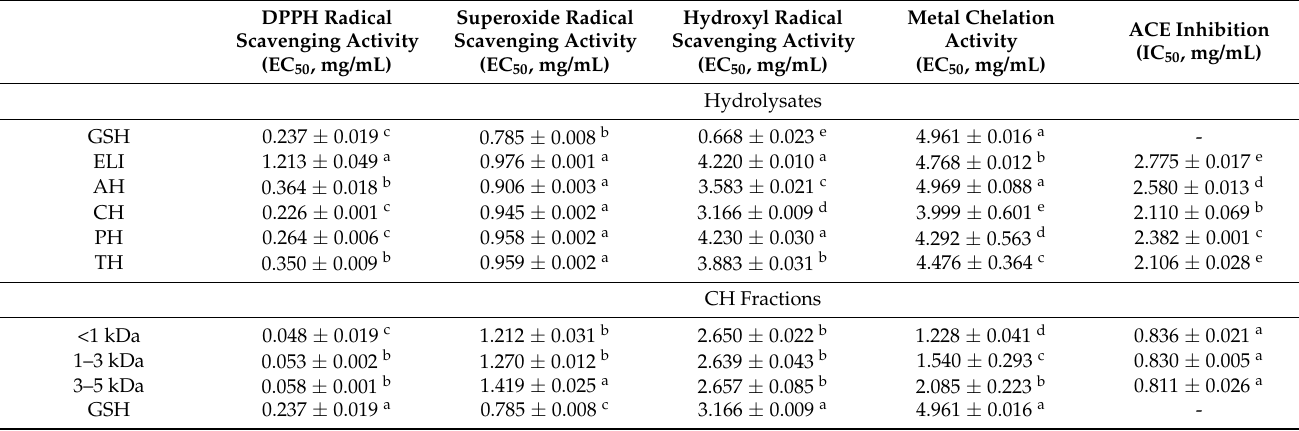
Table 3. Antioxidant activities and angiotensin-converting enzyme (ACE) inhibitory properties of eggplant leaf protein isolate, protein hydrolysates, chymotrypsin hydrolysate ultrafiltration peptide fractions and glutathione (GSH).